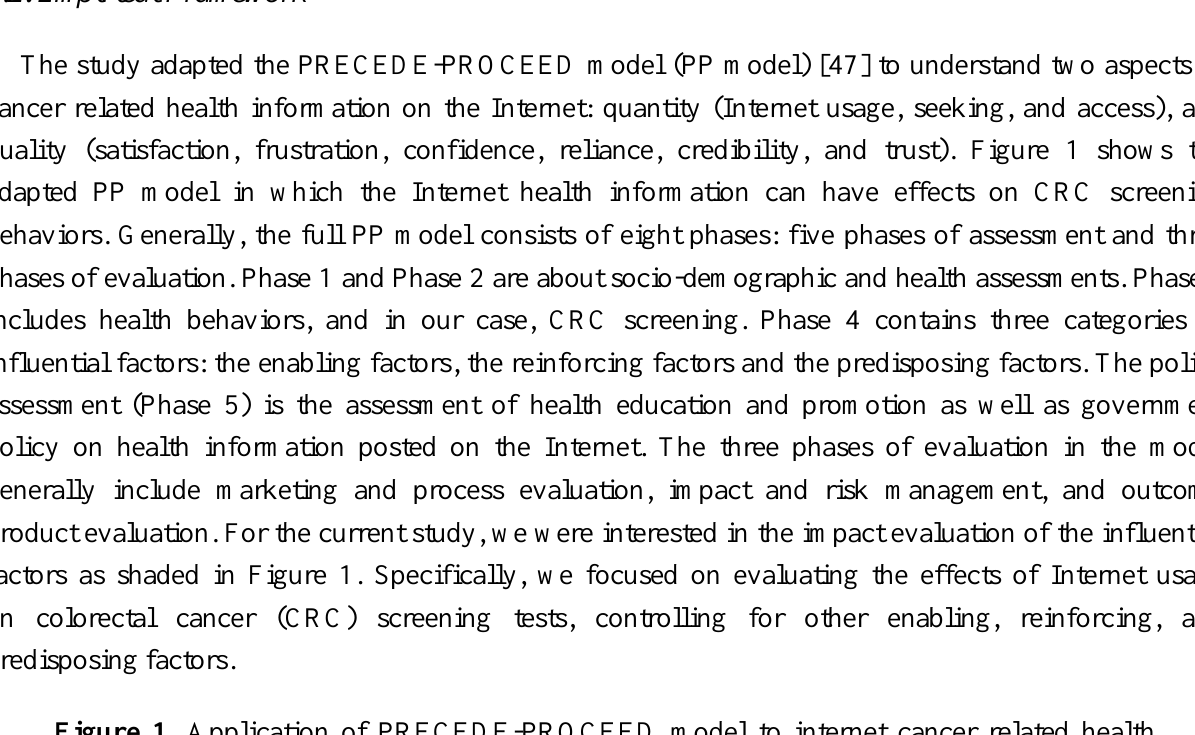
Figure 1. Application of PRECEDE-PROCEED model to internet cancer related health information and colorectal cancer (CRC)